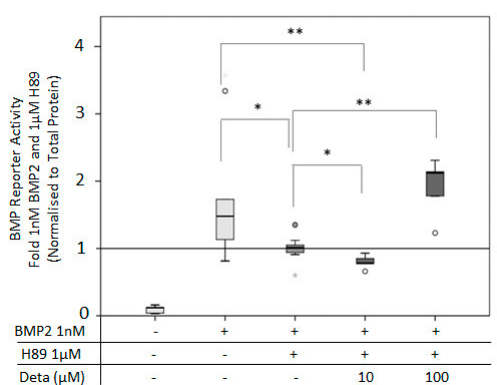
Figure 10. BMP reporter activity after inhibition of protein kinase A (PKA) by H89: BMP reporter activity of C2C12BRELuc cells stimulated for 6 h with 1 nM BMP2, 1 µ M H89, 10 and 100 µ M